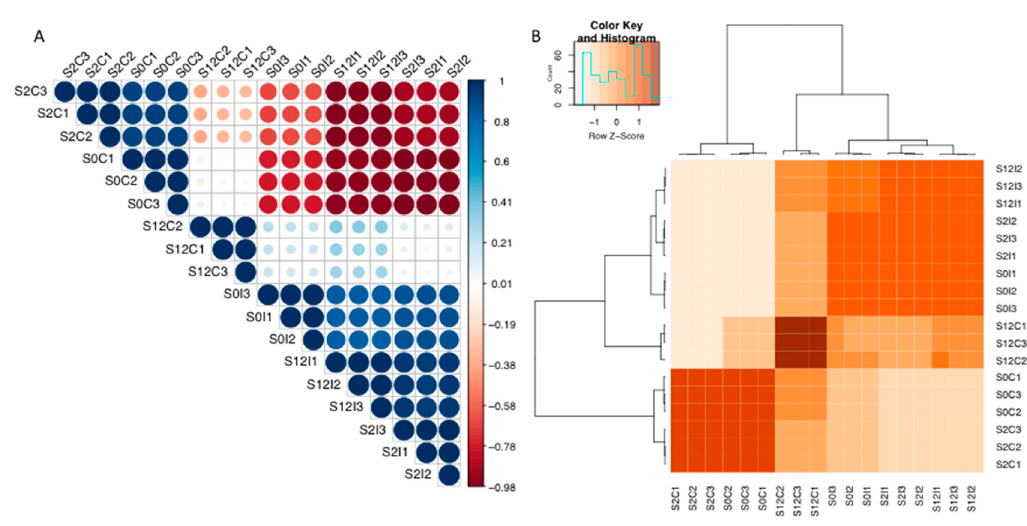
Figure 7. Baudin NILs mlo-11 ( cnv2 ) (S2), mlo-11 (S12), and Mlo wild-type control (S0) sample pairwise correlation coefficient plots of gene expression in Bgh inoculated (I) and noninoculated controls (C) for replicates 1–3. ( A ) Positive correlation coefficient (blue) and negative correlation (red) with dots sized by relative correlation p -values. ( B ) Heatmap samples are clustered by correlation coefficients. A count histogram is shown in the colour key for values.